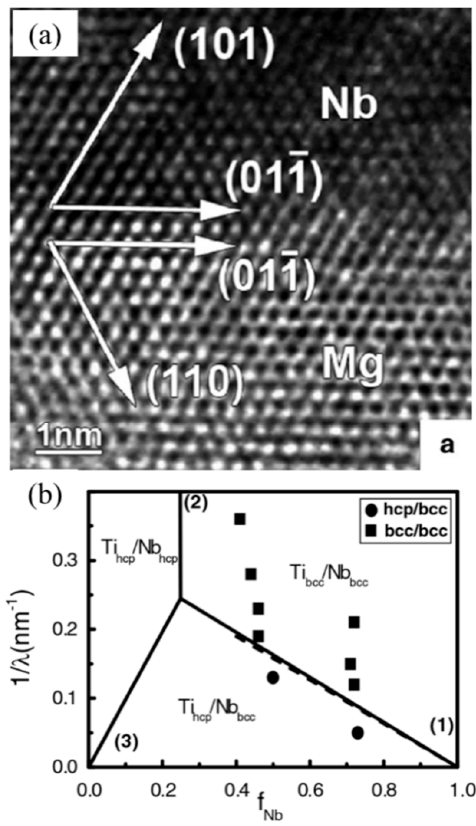
Figure 5. ( a ) HRTEM of the Mg/Nb multilayer shows the metastable bcc Mg; ( b ) The structure transformation diagram of Ti/Nb multilayers [21,26].